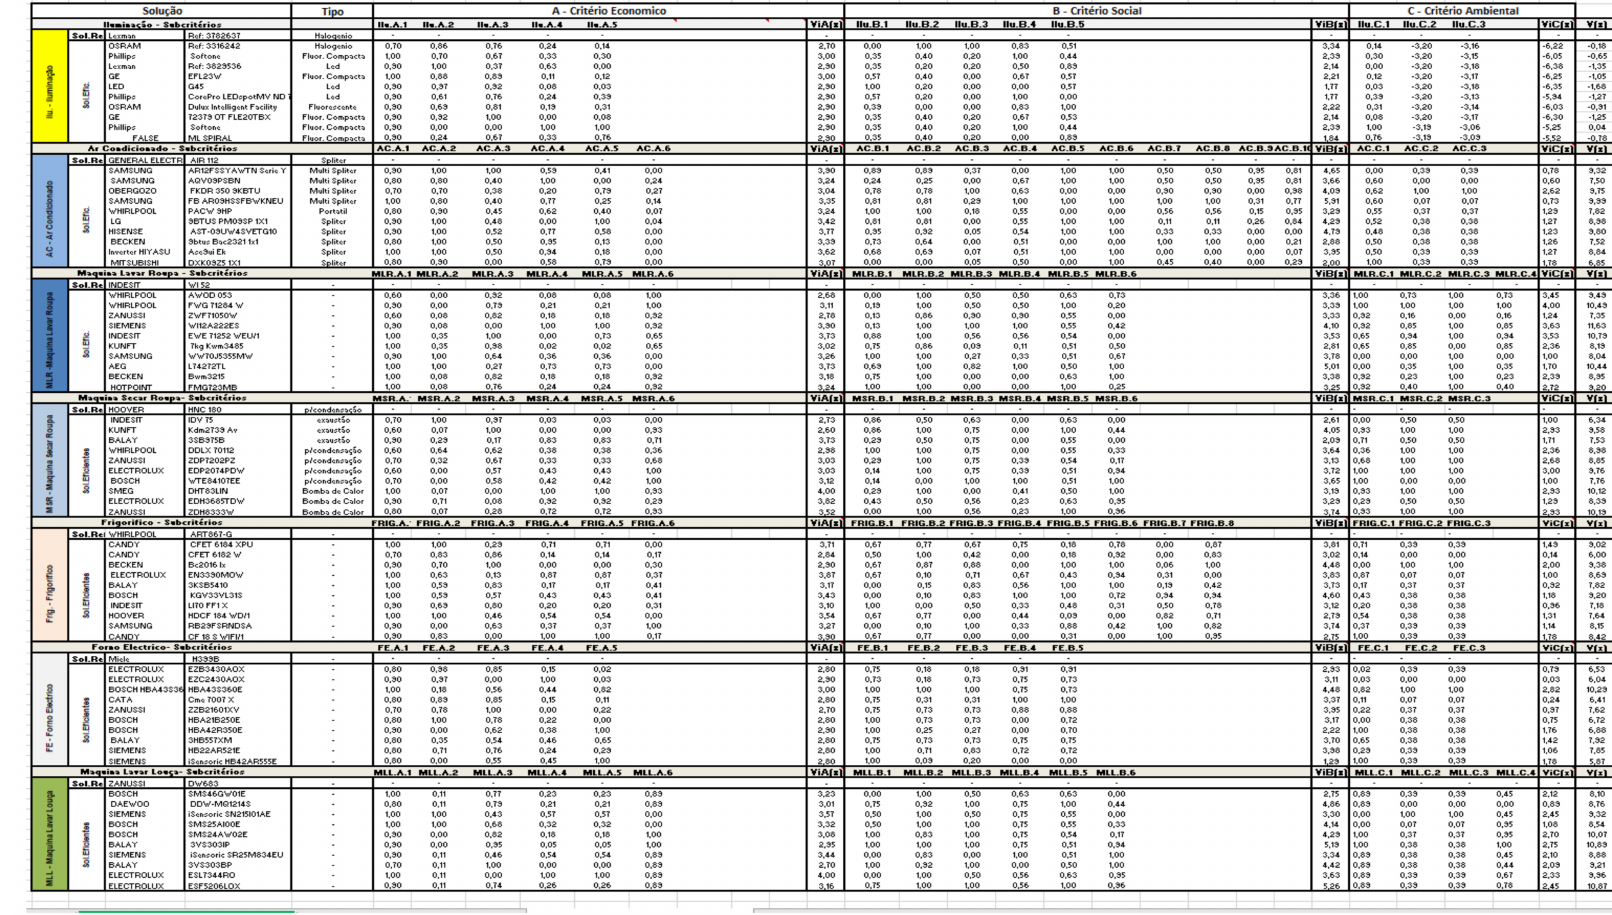
Figure A2. Definition of the table of values associated with the options available in the market that was considered in this